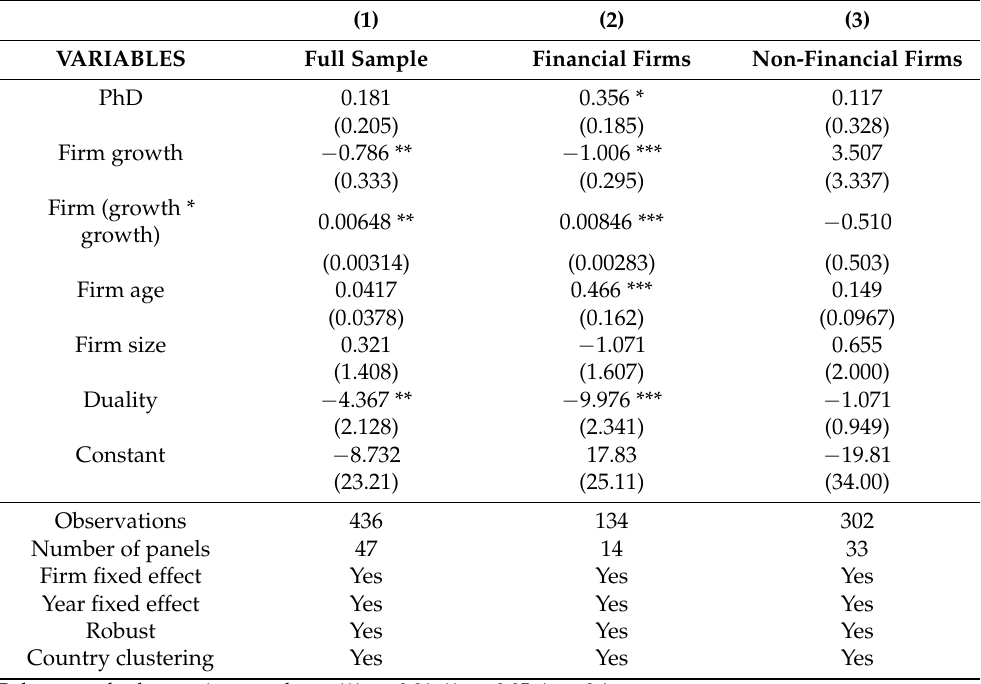
Table 6. The non-linear impact of firm’s growth on gender diversity in